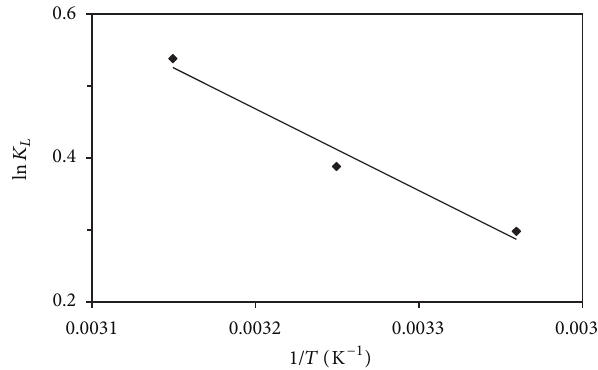
Figure 5: Plot of ln 𝐾 𝐿 versus 1/𝑇 for estimation of thermodynamic parameters for the adsorption of lead (II) ions onto the activated carbon (SAC2).